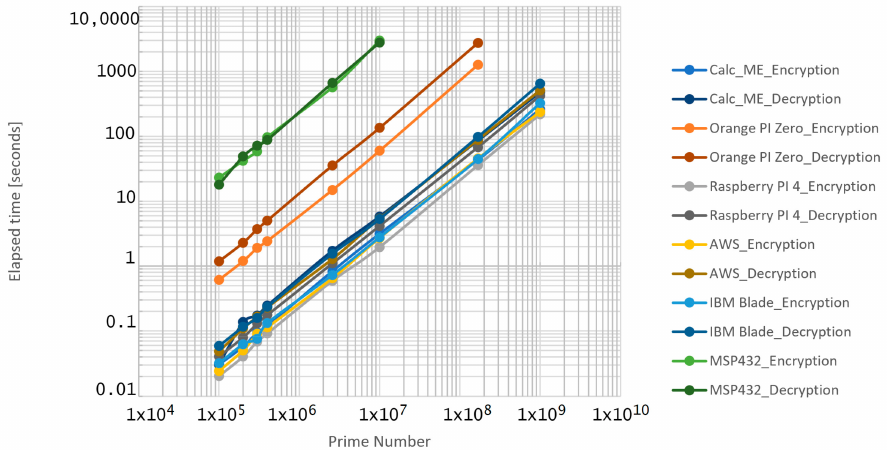
Figure 12. Encryption/decryption elapsed times for 101 entities in the